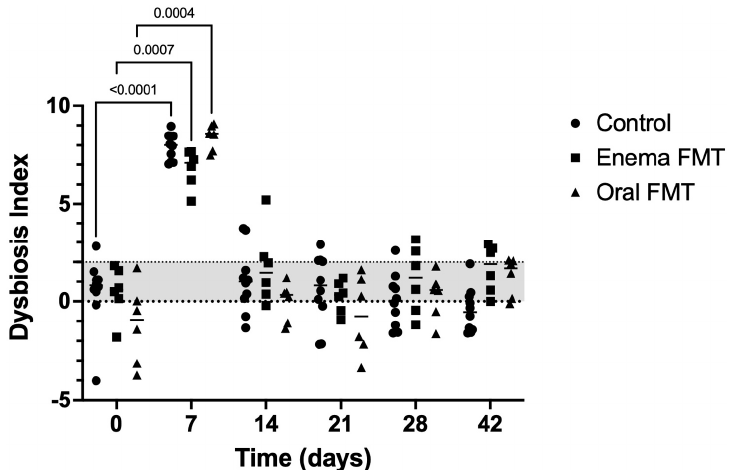
Figure 2. Dot plot graph representing the variation of the fecal dysbiosis index in control dogs, dogs receiving FMT by enema, and dogs receiving FMT orally over the 6-week duration of the study. Legend: Fecal dysbiosis index (FDI) < 0 is considered normal while a value between 0 and 2 is con- sidered to be equivocal, and FDI > 2 is abnormal. Dots represent individual values for each dog, bars denote median for the group. Statistically significant pairwise comparisons are shown.